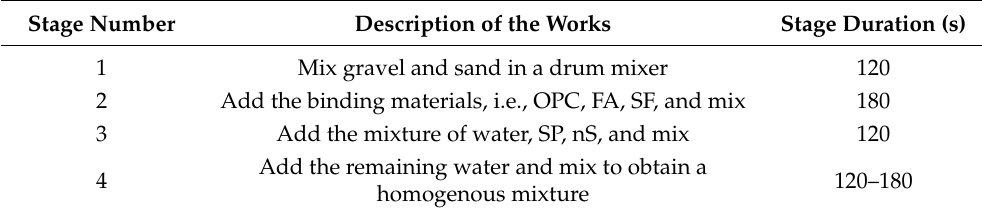
Table 4. Stages of the mixing procedure of concrete